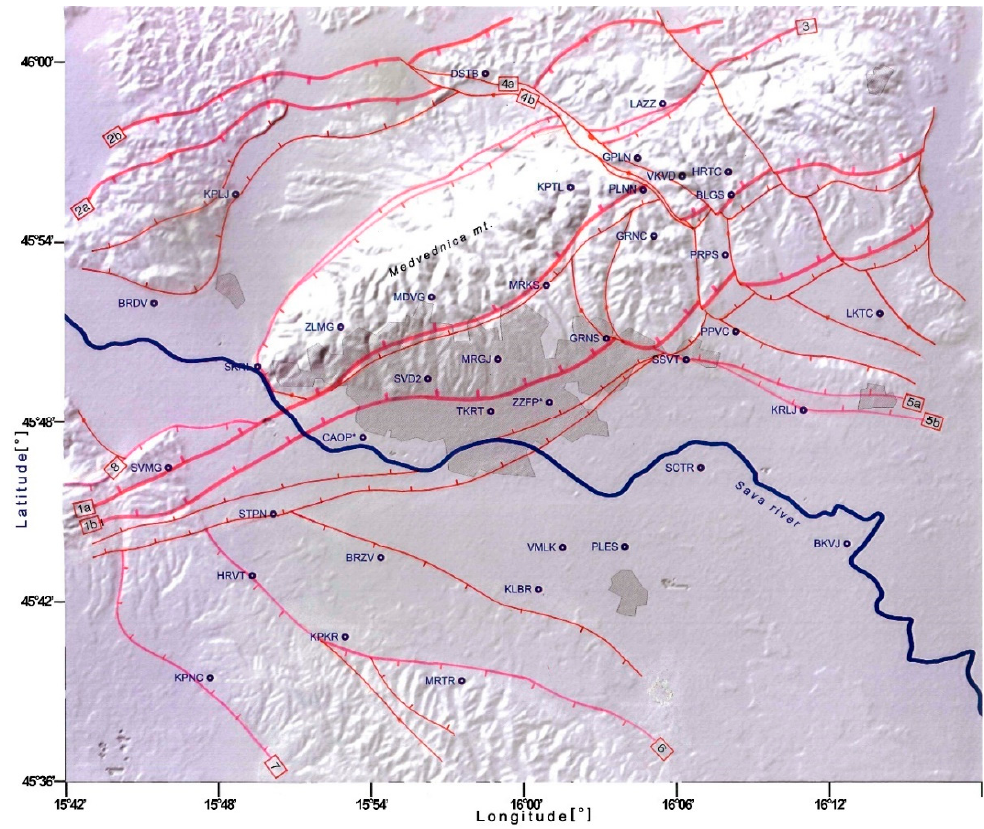
Figure 5. Configuration of the geodynamic network (blue dots with four ‐ letter names). Most important faults of the structural framework: Zagreb fault (1 a,b), Brežice ‐ Koprivnica fault (2 a,b), Bistra ‐ Laz fault (3 a,b), Stubica ‐ Kašina fault (4 a,b), Dugo Selo ‐ Ivani ć Grad ‐ Kutina fault (5 a,b), Vukomerice fault (6), Pokupsko fault (7), Sv. Nedjelja ‐ Plešivica fault (8).